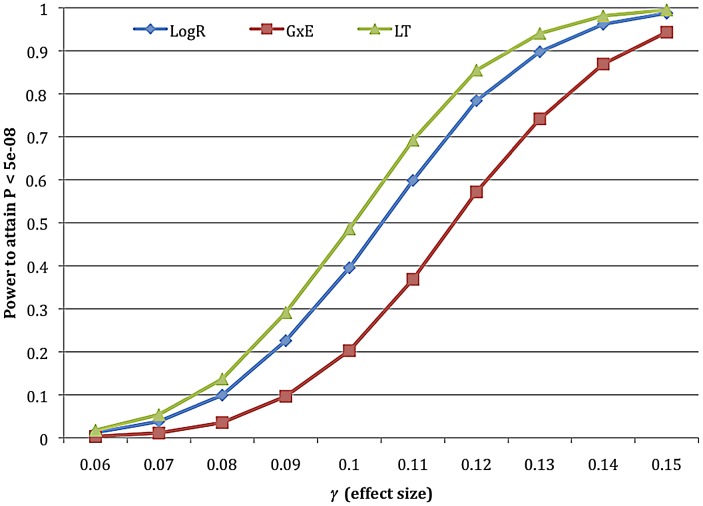
Power calculations for LogR, G+GxE, and LT approaches in simulated data.For each statistic we display power to attain P<5×10−8 based on 1,000,000 simulations of 3000 cases and 3000 controls, for various effect sizes γ. The increase in power (ratio of y-axis values) for LT versus LogR is 22.8% for γ = 0.1, and 23.0% when computing average power across all values of γ. For γ = 0 the power was 5.0% for all statistics when the P-value threshold is 0.05. G+GxE performs worse due to an extra degree of freedom.